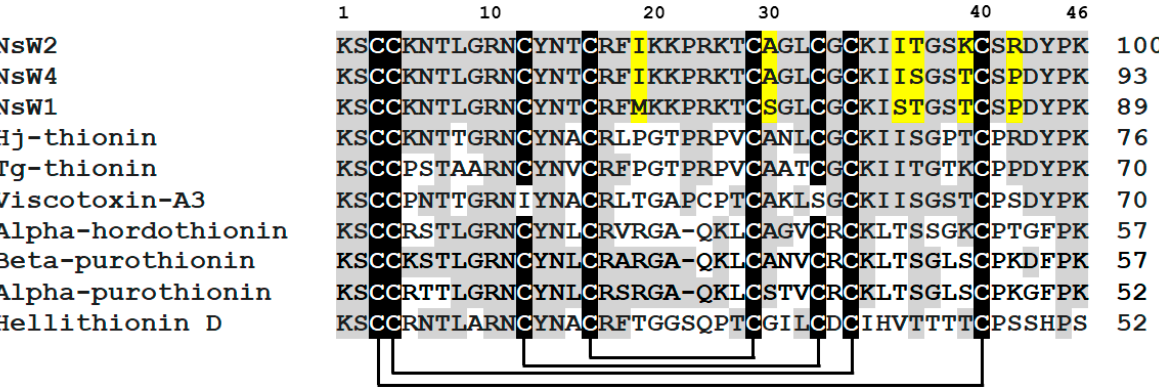
Figure 2. Multiple sequence alignment of nigellothionins and most homologous plant peptides deduced based on a BLASTP algorithm: NsW1, NsW2, and NsW4 from N. sativa ; Hj-thionin from Hordeum jubatum [14]; Tg-thionin from Tulipa gesneriana (GenBank ID: CAA57353.1); viscotoxin A3 from Viscum album [15]; alpha-hordothionin from Hordeum vulgare [16]; Alpha-purothionin from Triticum aestivum [17]; hellithionin D from Helleborus purpurascens [18]. Cysteine residues are indicated by a white type on a black background; all identical residues are colored white-gray (relative to the NsW2 structure, which is outlined with a frame); amino acid substitutions between the thionins from N. sativa are marked in yellow. The degree of sequence identity (relative to the NsW2 structure) is represented by ciphers.